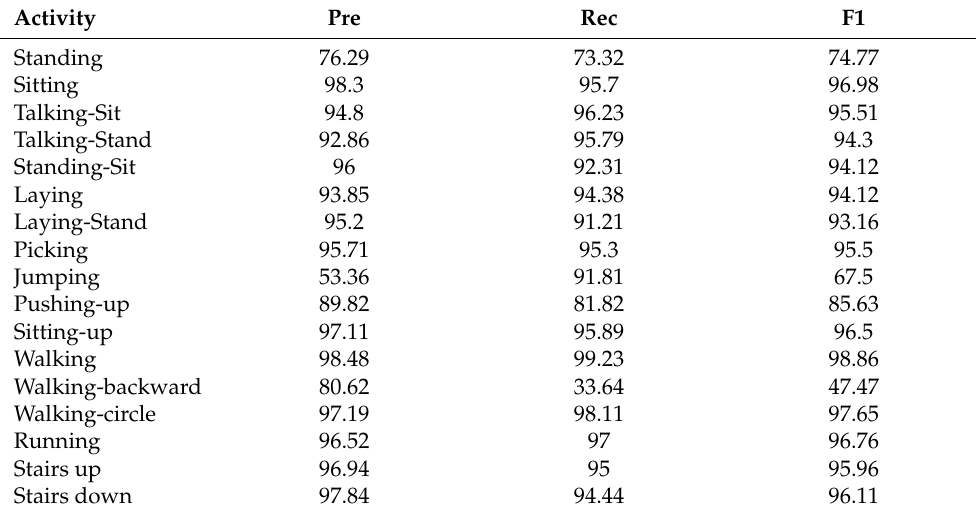
Table 5. Classification rates (%) of the best model of the KUHAR dataset using RF.